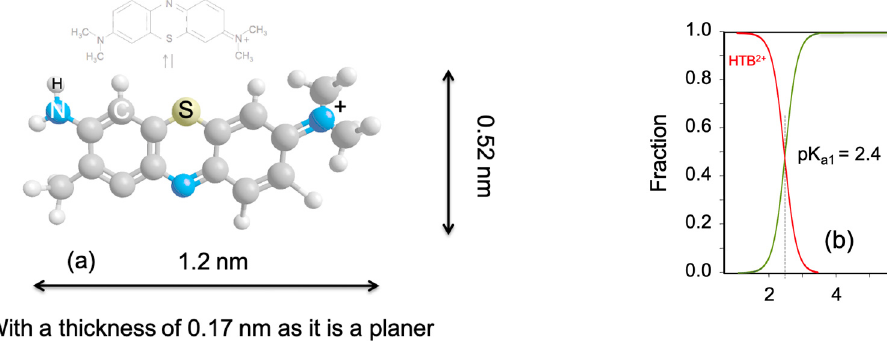
Figure 1. Molecular structure of TB ( a ) and its pH-speciation ( b ).